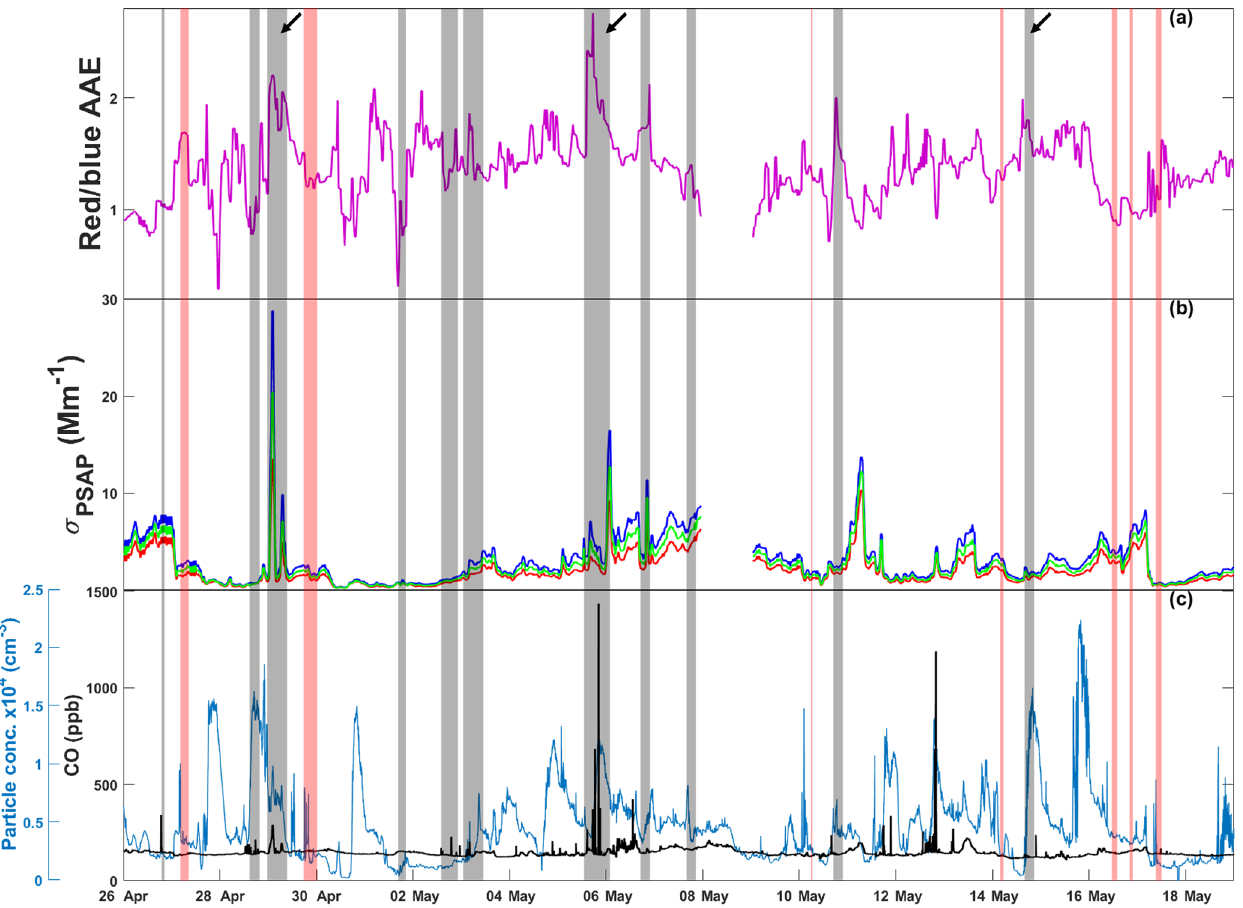
Figure 1. Time series for (a) absorption Ångström exponent (AAE) calculated from red and blue absorption coefficients (reported in units of reciprocal megameters), (b) absorption coefficients measured at red (660nm), green (522nm), and blue (470nm) wavelengths, and (c) CO mixing ratio and ambient particle concentration. Gray vertical bars indicate sampling periods where microscopy samples were collected. Red vertical bars represent rain events. Arrows indicate the three sampling periods investigated in the current work where BrC particles were expected. PSAP data for 8 May are not available due to instrument